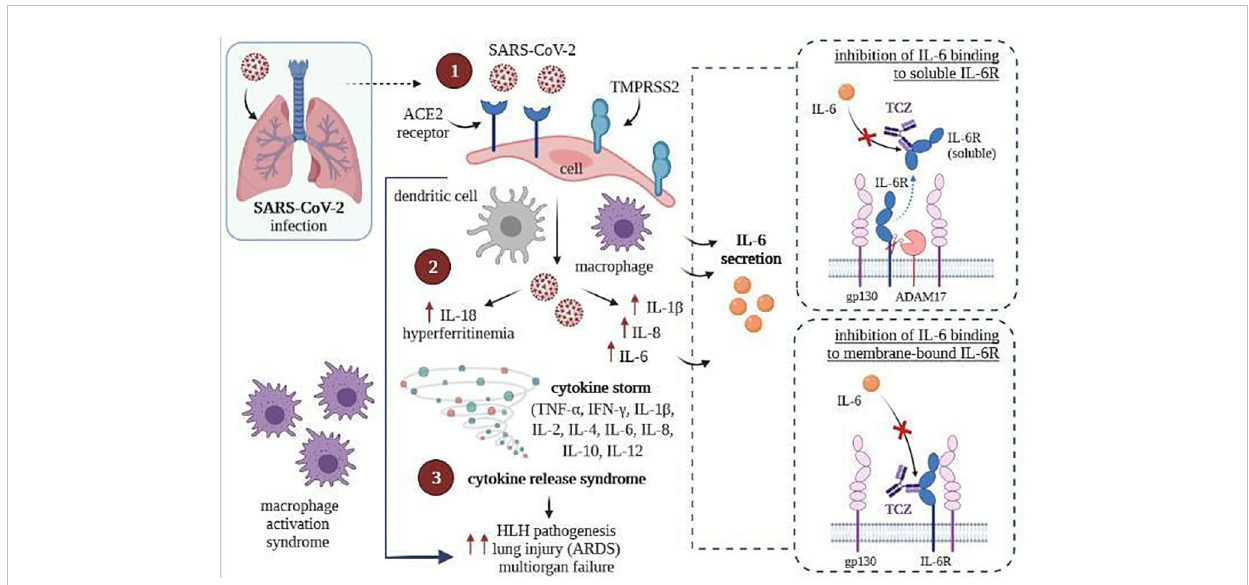
FIGURE 4 SARS-CoV-2 infection (left) and inhibition of intracellular signaling in cells by TCZ, resulting express of gp130 (right) [own drawing]. (1) Virus entry and infection of pneumocytes expressing the ACE2 receptor, recruiting antigen-presenting cells (dendritic cells and macrophages) into the lungs; (2) Activation of the NLRC4 in fl ammasome, which causes the overproduction of IL1 b and IL 18, and causes the secretion of IL6 and ferritin by macrophages; (3) Upregulation resulting in cytokine release syndrome and macrophage recruitment to the lungs, contributing to